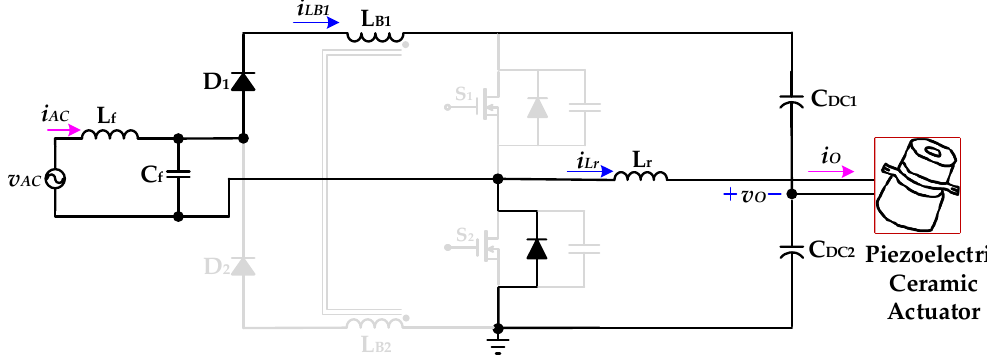
Figure 9. Operation Mode 4 of the proposed drive circuit for the piezoelectric ceramic actuator. 2.2.5. Operational Mode 5 (t 4 ≤ t < t 5 ) Figure 10 shows the operational Mode 5 of the new piezoelectric ceramic actuator drive circuit with PFC. The resonant inductor L r and the parasitic capacitance of the power switch S 1 charge the DC-linked capacitor C DC1 and provide energy to the piezoelectric ce- ramic actuator. At the same time, the resonant inductor L r and the DC-linked capacitor C DC2 charge the parasitic capacitance of the power switch S 2 and provide energy to the piezoelectric ceramic actuator. When the parasitic capacitance energy of the power switch S 1 is released and the voltage v DS1 of the power switch S 1 drops to zero, the essential diode of the power switch S 1 is forwardly biased and turned on. At time t 5 , Mode 5 completes.